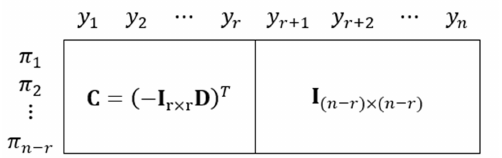
Fig. 3. Matrix constructed for π i calculation in the direct transformation method.